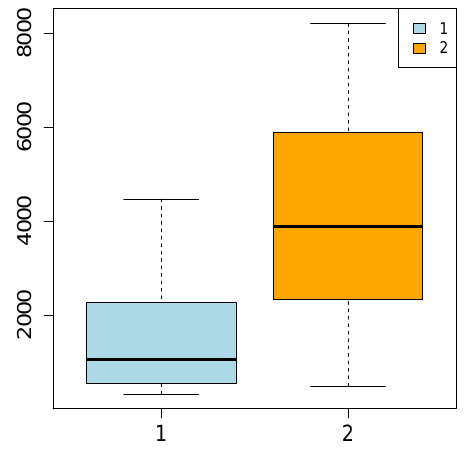
Figure 4. Boxplot of the variable “GDP” in clusters 1 and 2.